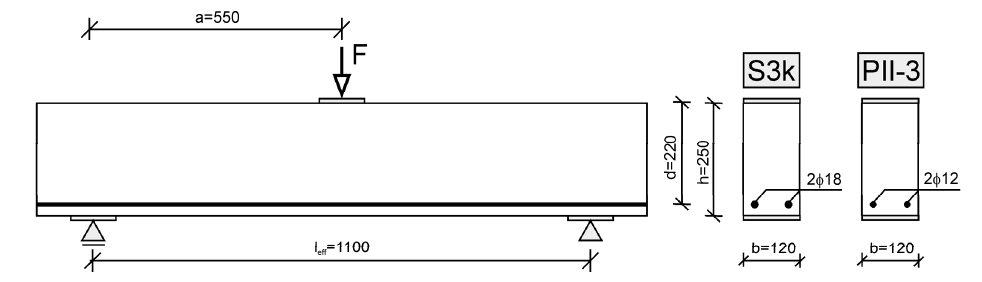
Figure 4. Details of test beams (unit in mm).